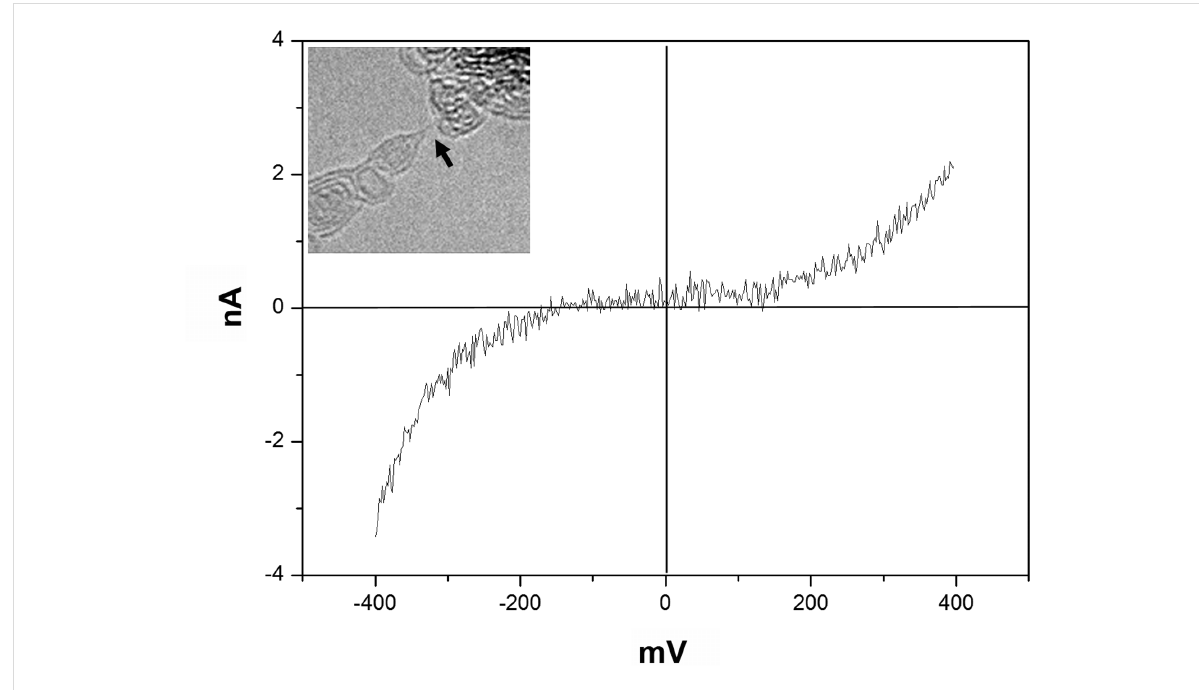
Figure 4: Measured current–voltage characteristic of a carbon chain (measurements by A. La Torre). A TEM image of the chain is shown in the